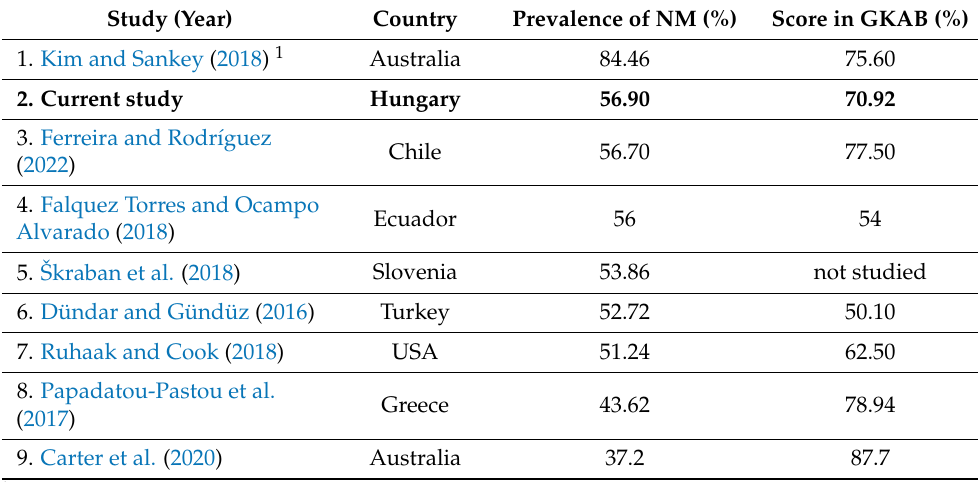
Table 6. Prevalence of neuromyths (i.e., rates of incorrect answers to NM statements) and GKAB scores (i.e., rates of correct answers to GKAB statements) across